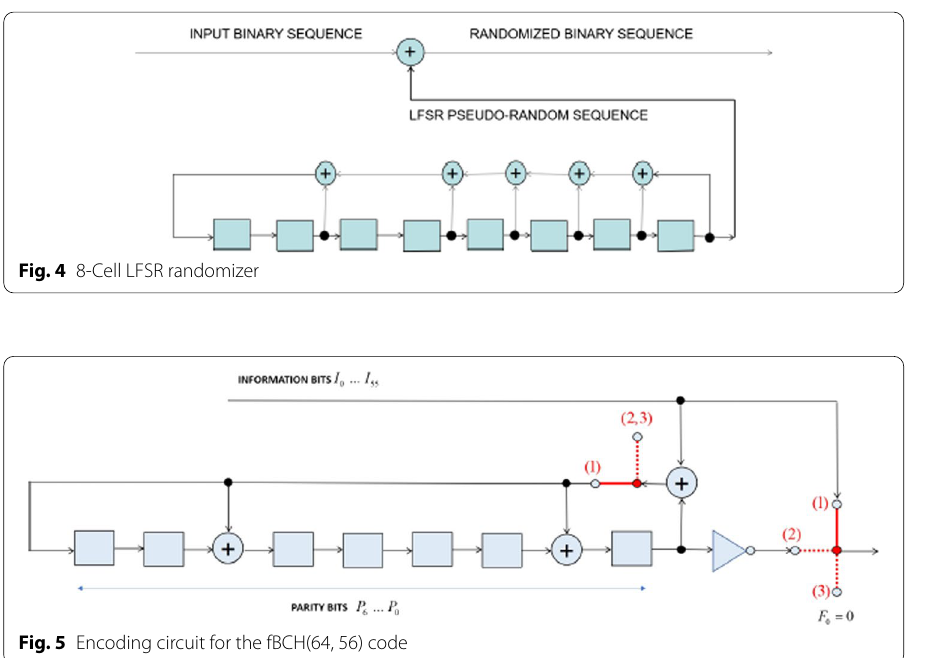
Fig. 5 Encoding circuit for the fBCH(64, 56)